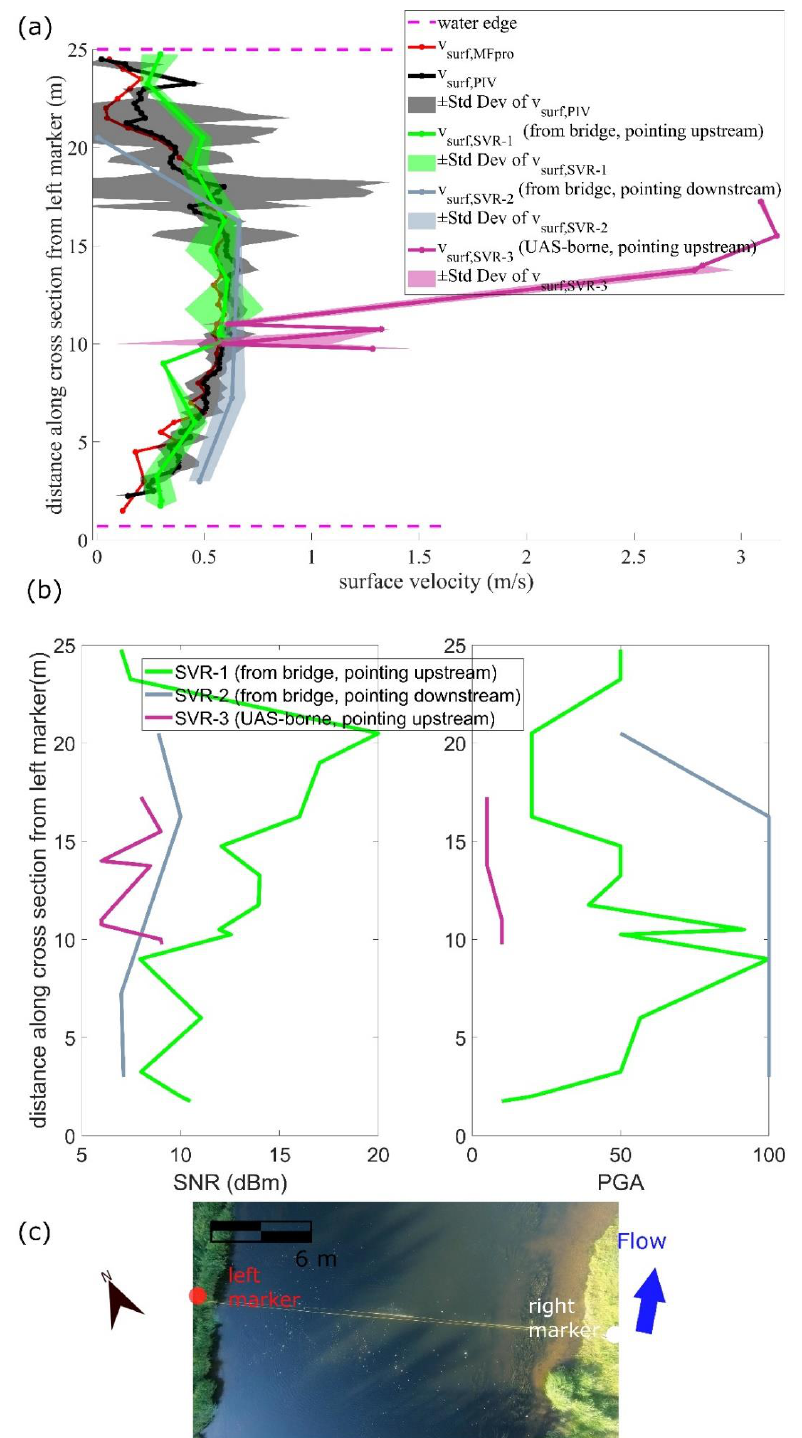
Figure 5. Guden_GamleSkibelundvej XS (DK). ( a ) Surface velocity comparing: MFpro measurements of surface velocity (v surf,MFpro ), UAS-borne PIV measurements (v surf,PIV ) and three SVR surveys. Two SVR are retrieved from bridge, i.e., v surf,SVR-1 (pointing upstream), v surf,SVR-2 (pointing downstream), whilst one from UAS, i.e., (v surf,SVR-3 , pointing upstream). SVR and PIV are represented with shaded regions to present standard deviation ( ± Std Dev). ( b ) Comparison of two quality indicators (SNR and PGA) for the three SVR surveys. ( c ) UAS-borne video frame of the XS (North arrow, approximate flow direction and approximate scale are also